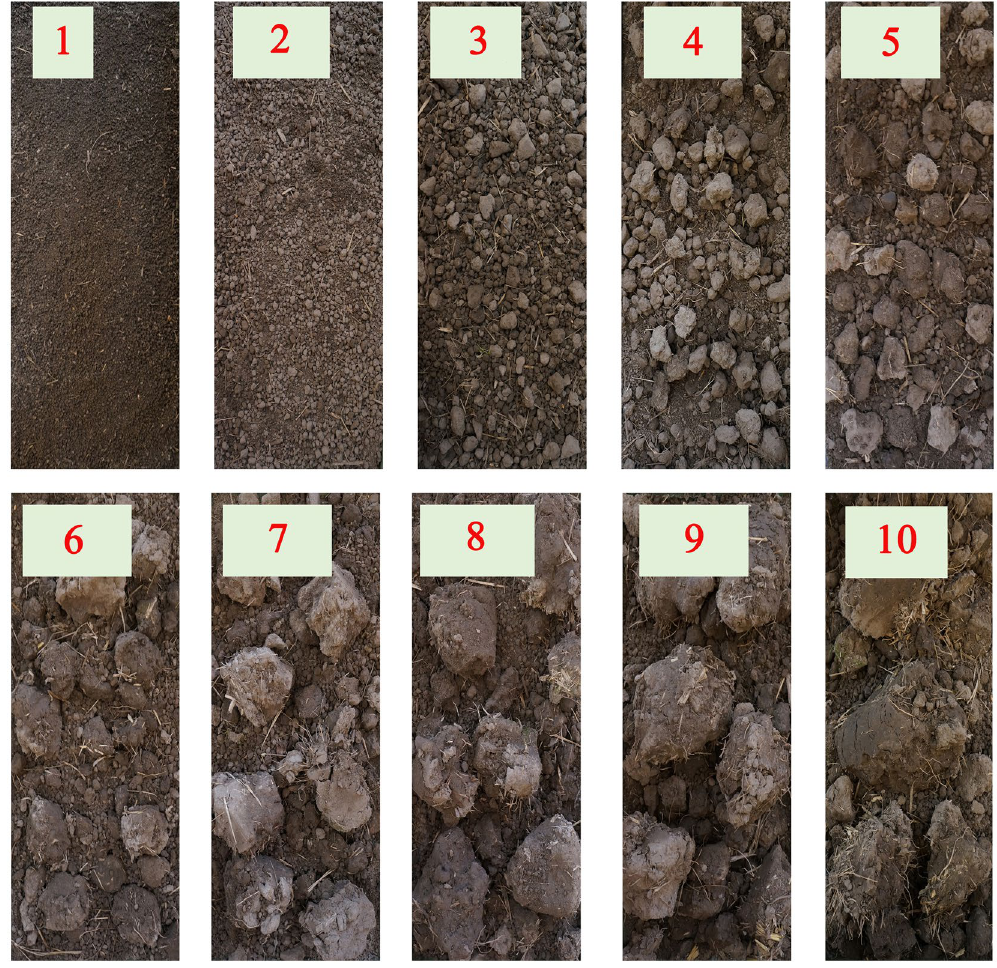
Figure 1. Vertical images of the different grades of